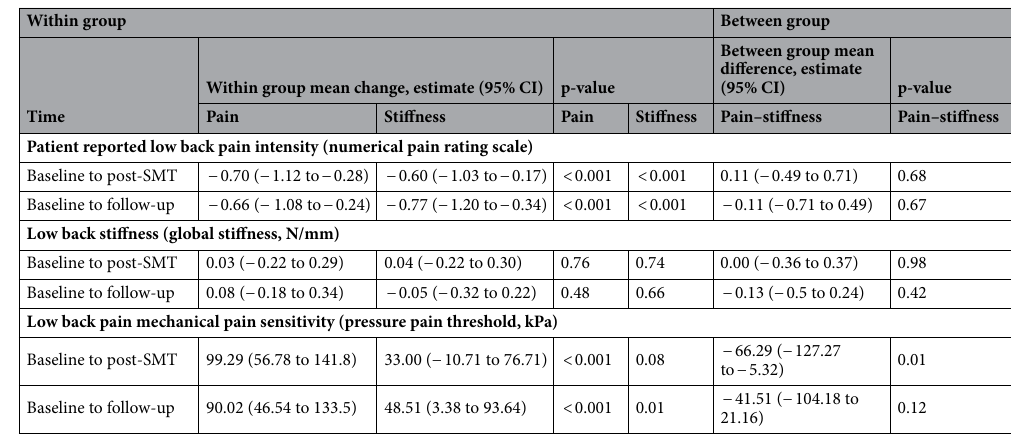
Table 3. Changes in patient reported low back pain intensity, lumbar stiffness and pressure pain threshold in participants with persistent low back pain who are treated with spinal manipulative therapy over 4 sessions at either a pain segment or a stiff segment . Within mean changes and between group mean differences are presented as mean differences between baseline and post-SMT/follow-up and between group mean with 95% confidence